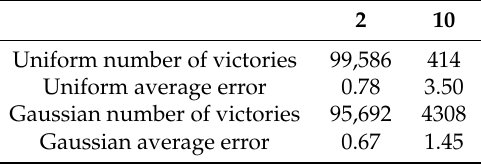
Table 10. k = 2 vs. 10 with rounding compression. For k = 10 only scores permitted between 3 and